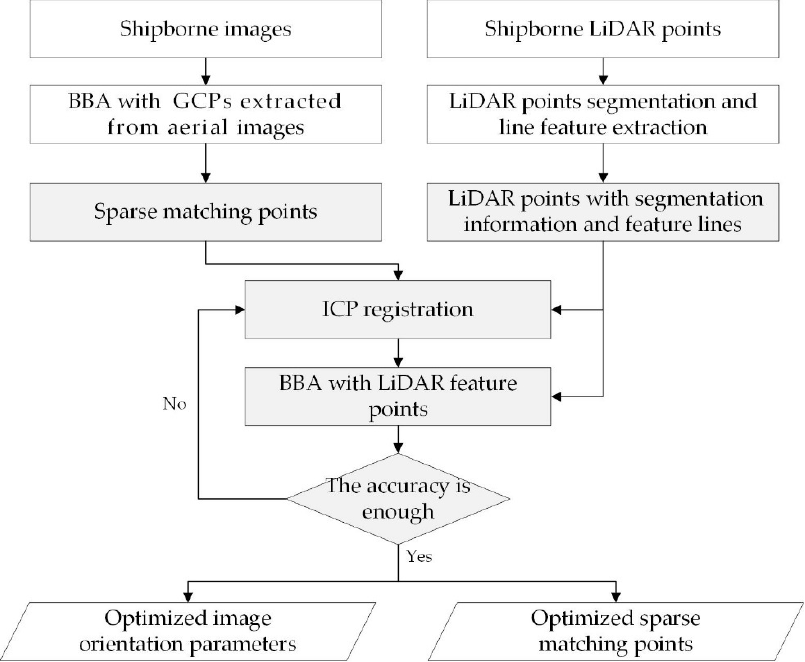
Figure 8. Flowchart of BBA with LiDAR point cloud as the control.